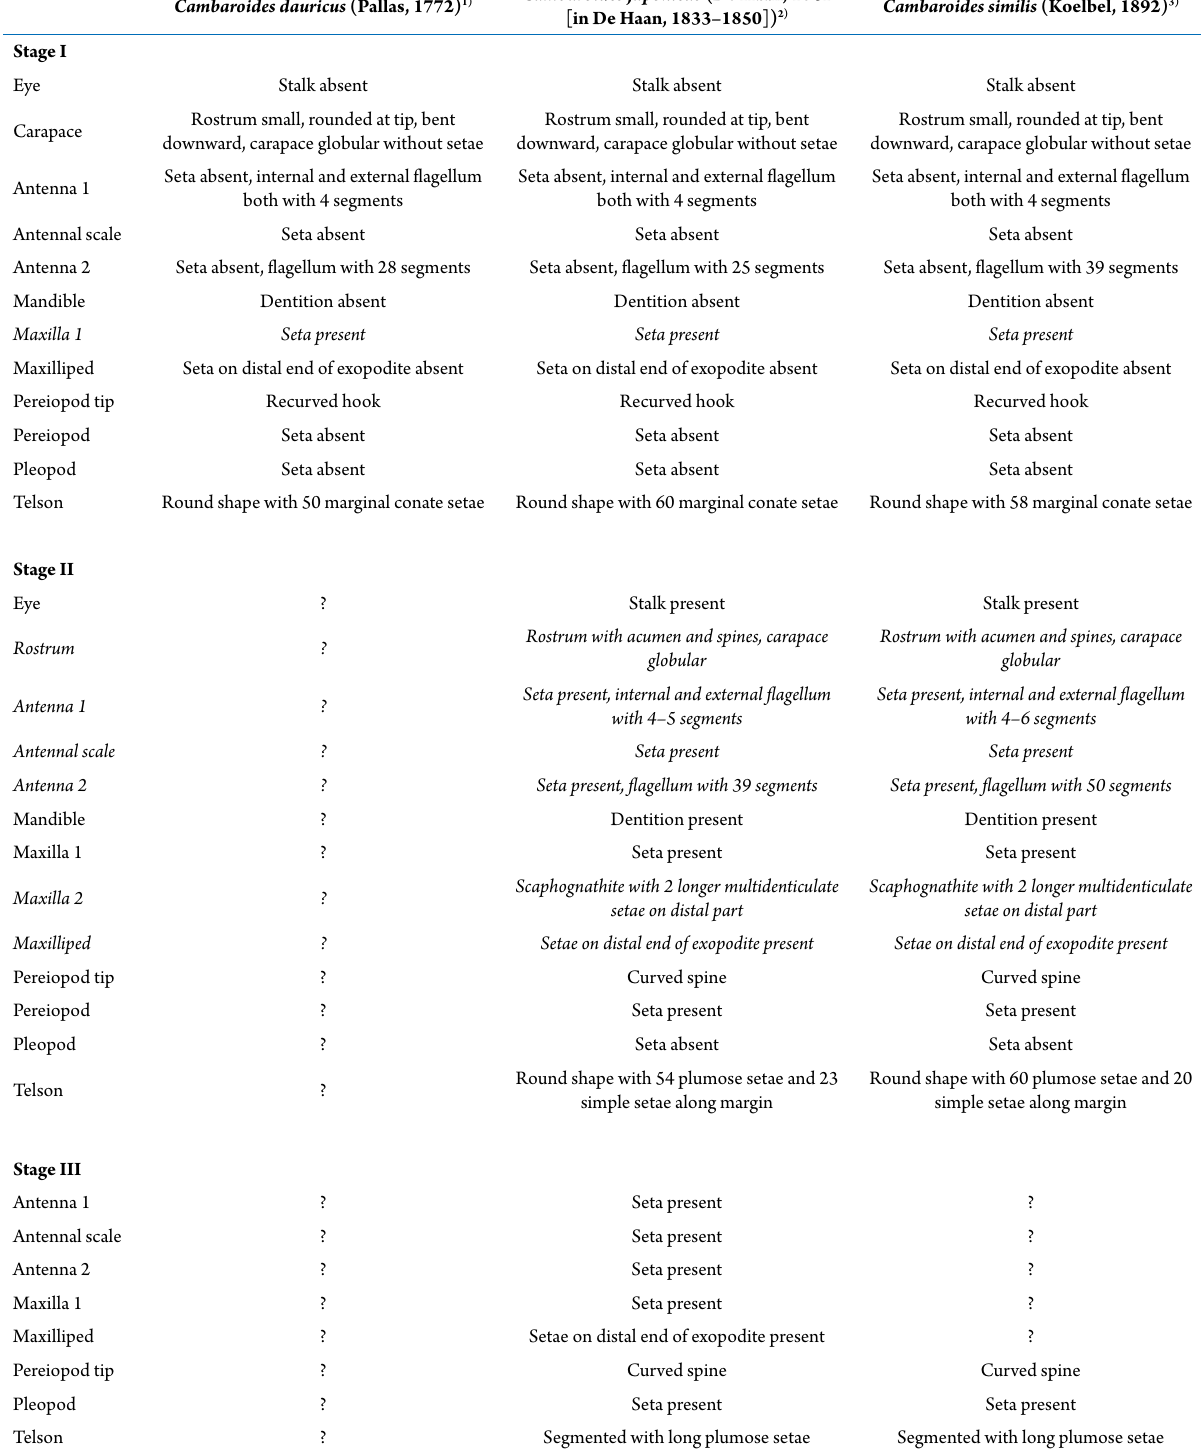
Table 3. Comparison of the morphology of postembryonic stages of Cambaroididae members. Cambaroides japonicus (De Haan, 1841 Cambaroides dauricus (Pallas, 1772) 1) Cambaroides similis (Koelbel, 1892) [in De Haan, 1833–1850]) 2)